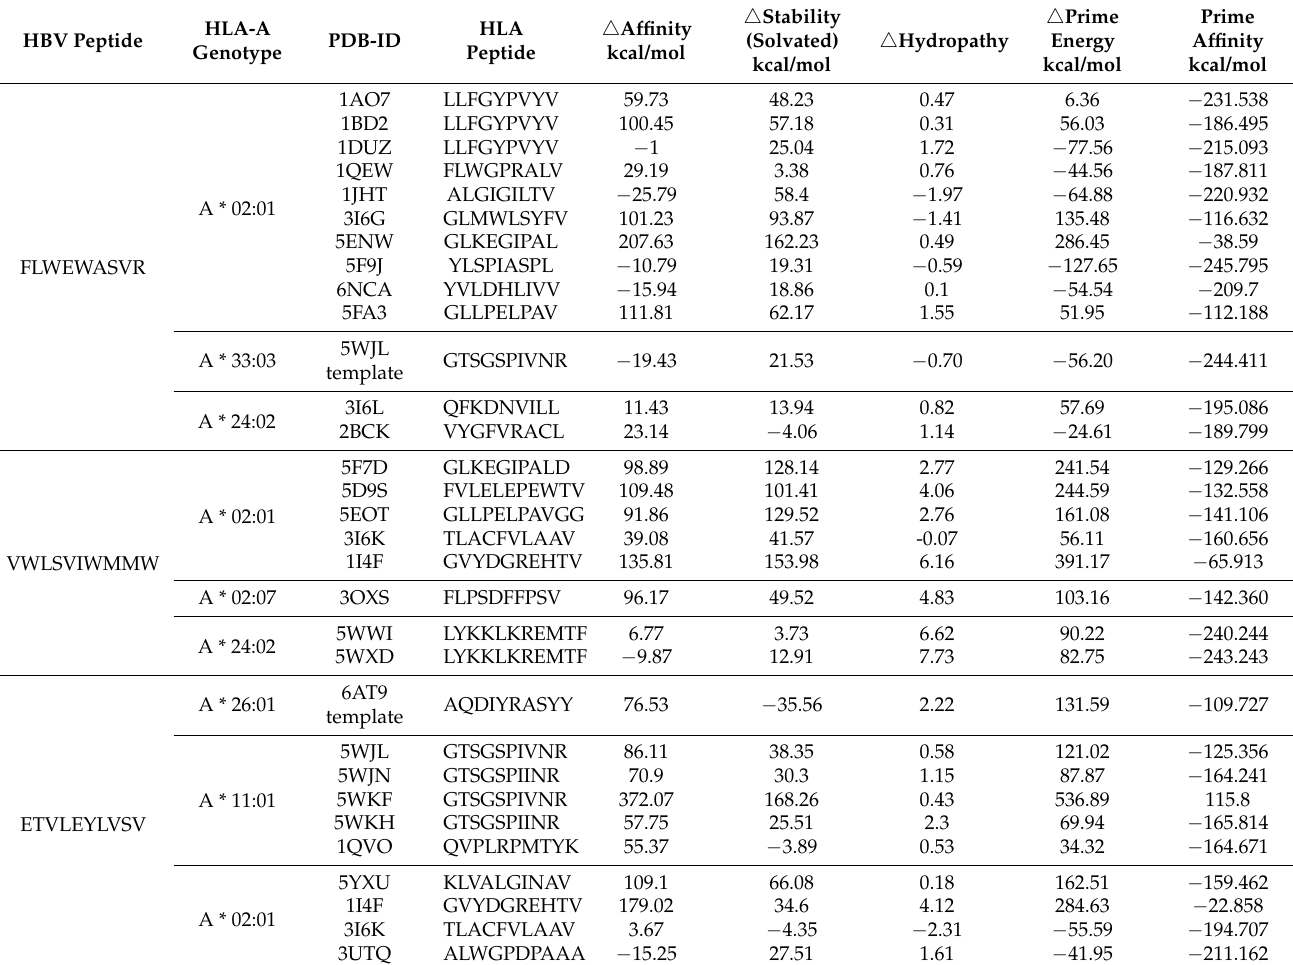
Table 3. Part of the HLA mutation performance.